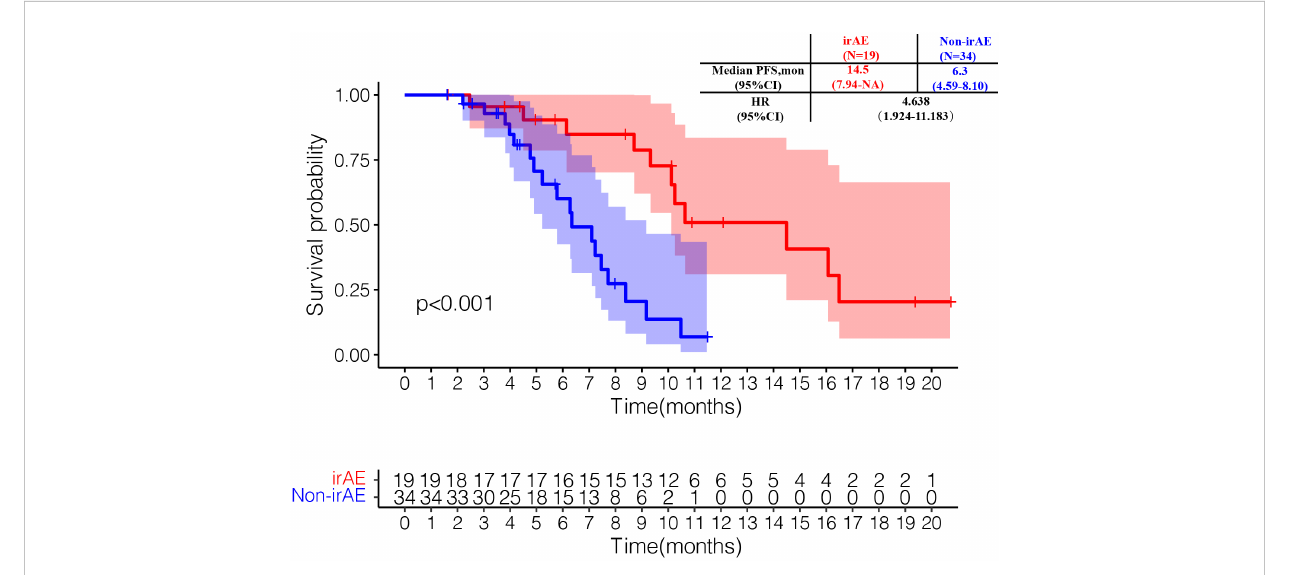
FIGURE 2 Kaplan-Meier curves of progression-free survival by immune-related adverse events (irAEs) in the irAE-evaluable